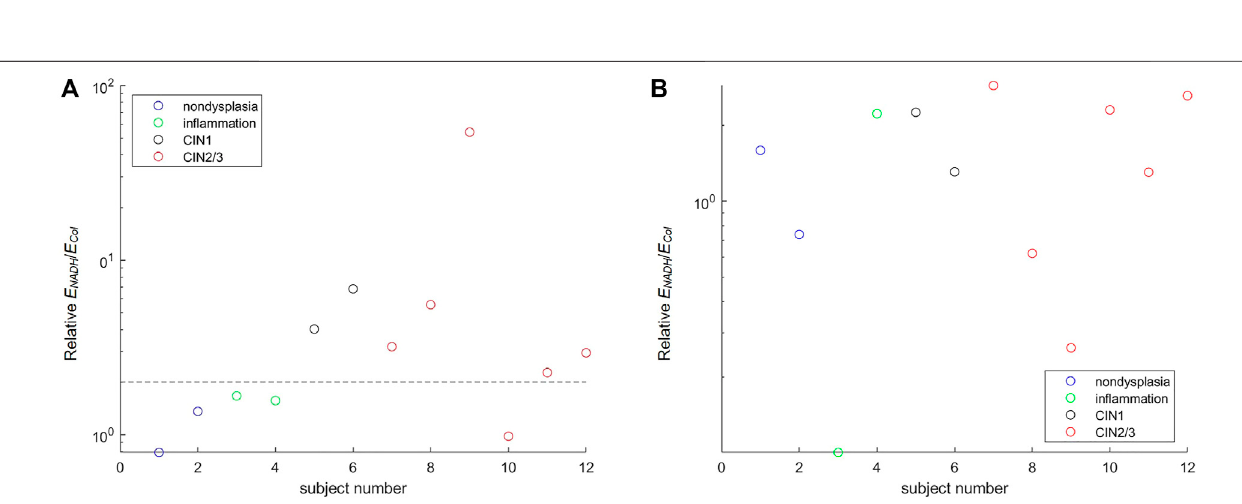
FIGURE 8 | Results of fi tting one set of in-vivo spectra (A) Re fl ectance spectra with spectral errors of 7 and 14% in the results of two-layer and one-layer forward model,respectively (B) Fluorescencespectrawithspectralerrorsof12and21%intheresultsoftwo-layerandone-layerforwardmodel,respectively.Threespectrafrom the strongest to the weakest in each group represent the spectrum measured at the SDS of 0.22, 0.41, and 0.61 mm, respectively.